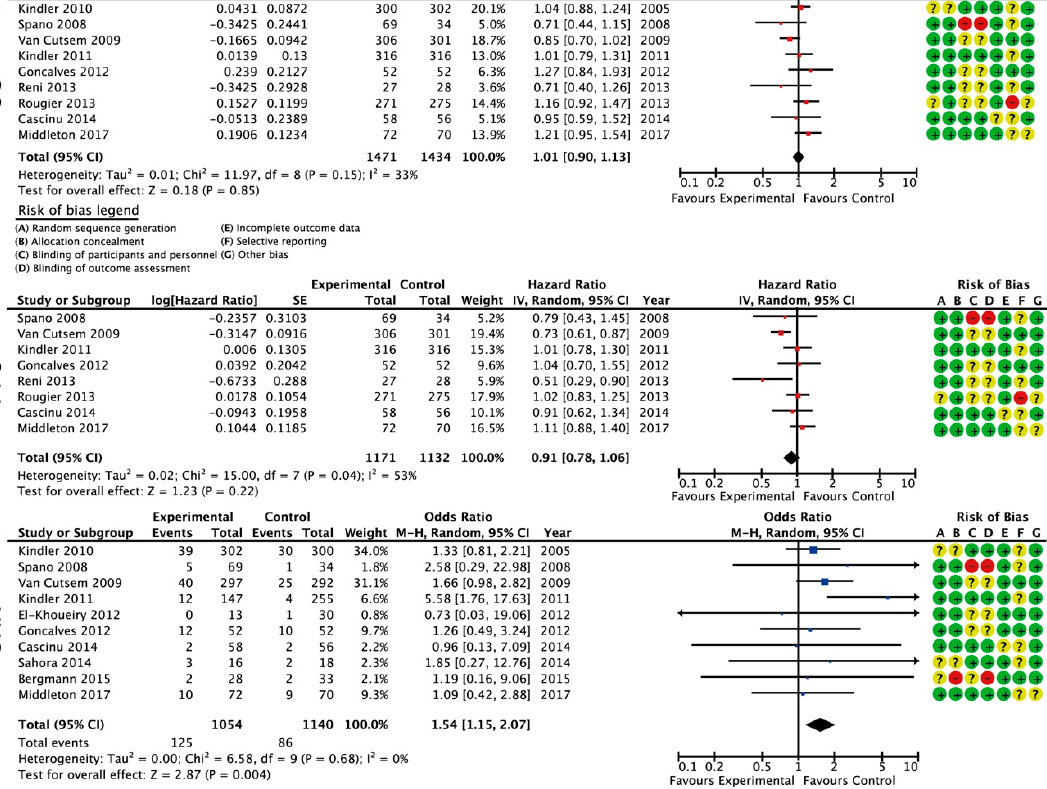
Figure 3. Meta-analysis results of treatment with anti-angiogenic therapies for overall survival, ( A ) progression free survival ( B ) overall objective response rate ( C ) with random effects model. HR = hazard ratio, CI = confidence interval, IV = inverse-variance approach, M-H = Mantel-Haenszel test. Red: high risk of bias, Green: low risk of bias, Yellow: unclear risk of bias.